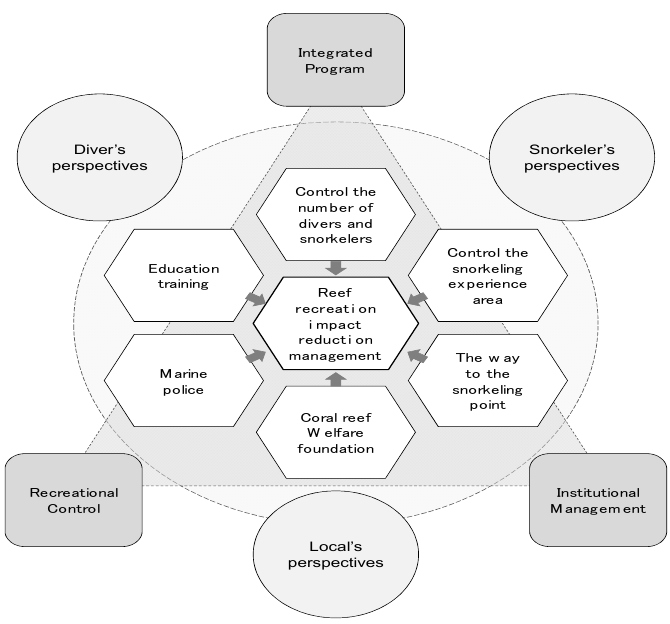
Figure 2. The conceptual framework for an impact reduction program in a reef recreational area.